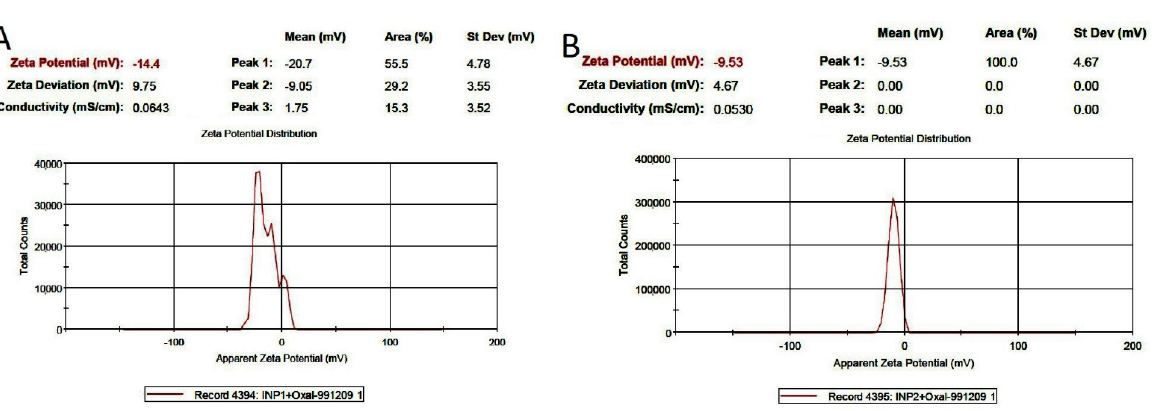
Figure 3. TEM ( A ) and SEM ( B ) photographs of iodine nanoparticles coated with chitosan (INP2).